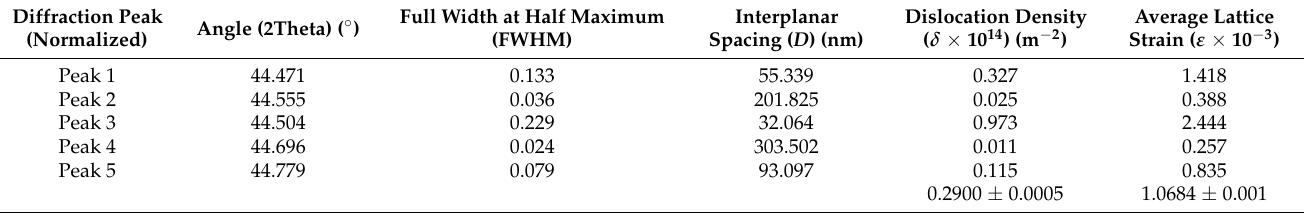
Table 1. Peak parameters such as crystallite size ( D ), dislocation density ( δ ), micro-strain ( ε ) for five sub-peaks using the self-made numerical process of Gaussian multiple of as-received